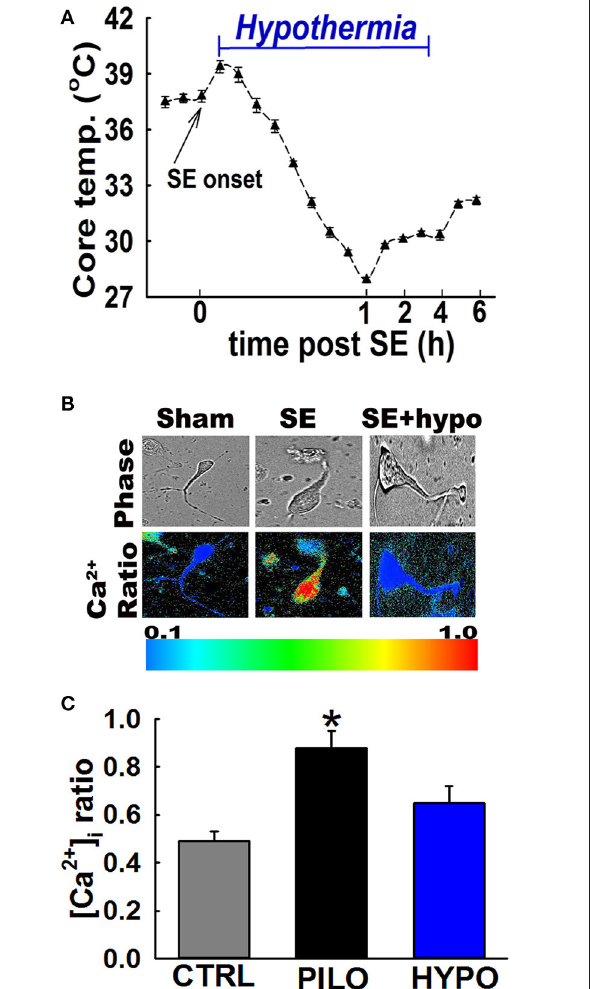
FIGURE 3 | Hypothermia blocked the Ca 2 + plateau after in vivo SE. (A) Hypothermia in rats was induced using surface cooling methods.